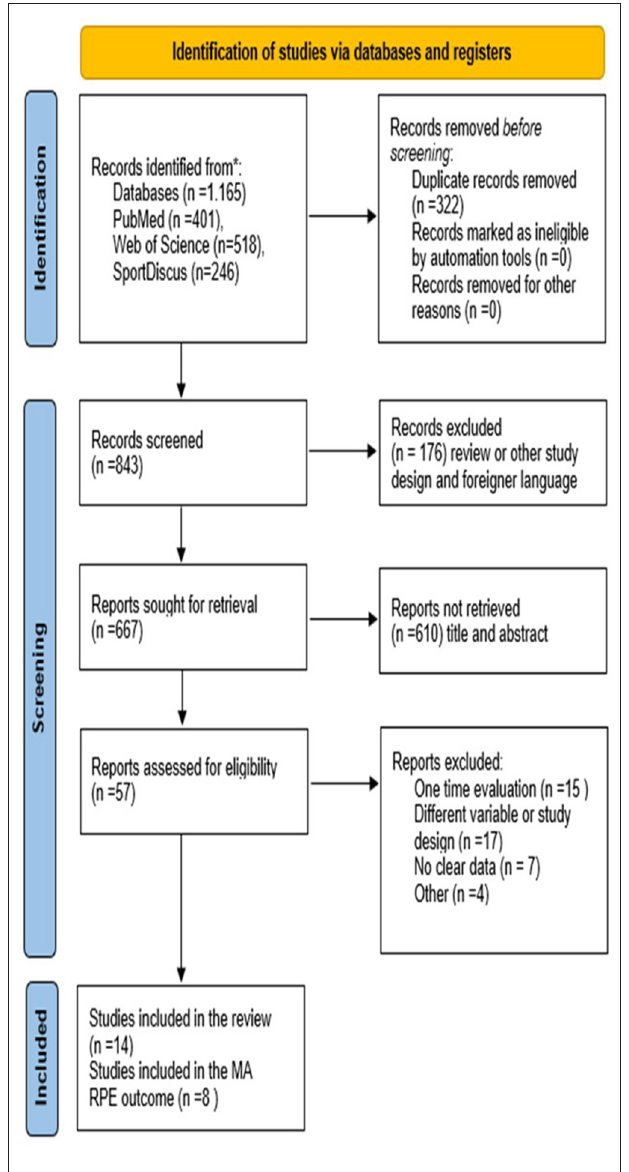
FIGURE 1 | Flow chart diagram of the study process (PRISMA